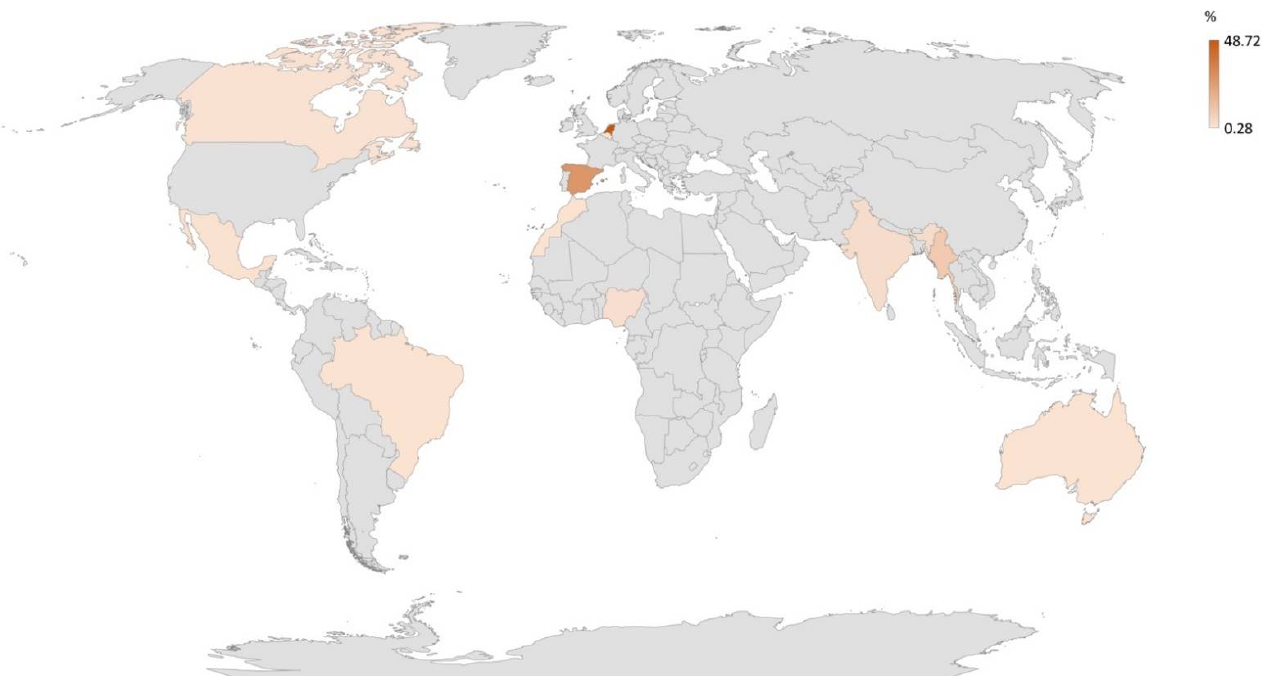
Table 1. Sociodemographic description of all participants, stratified for low- and middle-income (LMICs) and high-income countries (HICs). Differences between subsets were analyzed by Fisher’s exact test. Significance: *** p < 0.001, and ** p < 0.01.